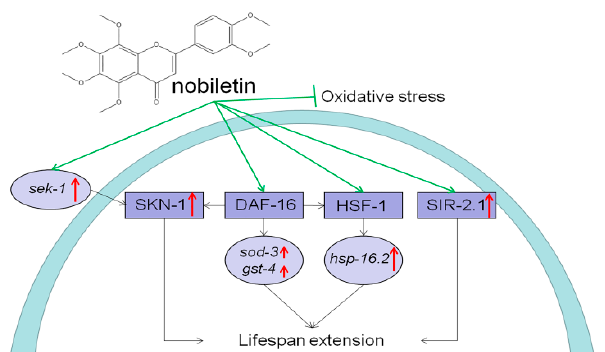
Figure 10. A possible mechanism of action through DAF-16 signalling pathway in C. elegans representing molecular targets for modulation by NOB.